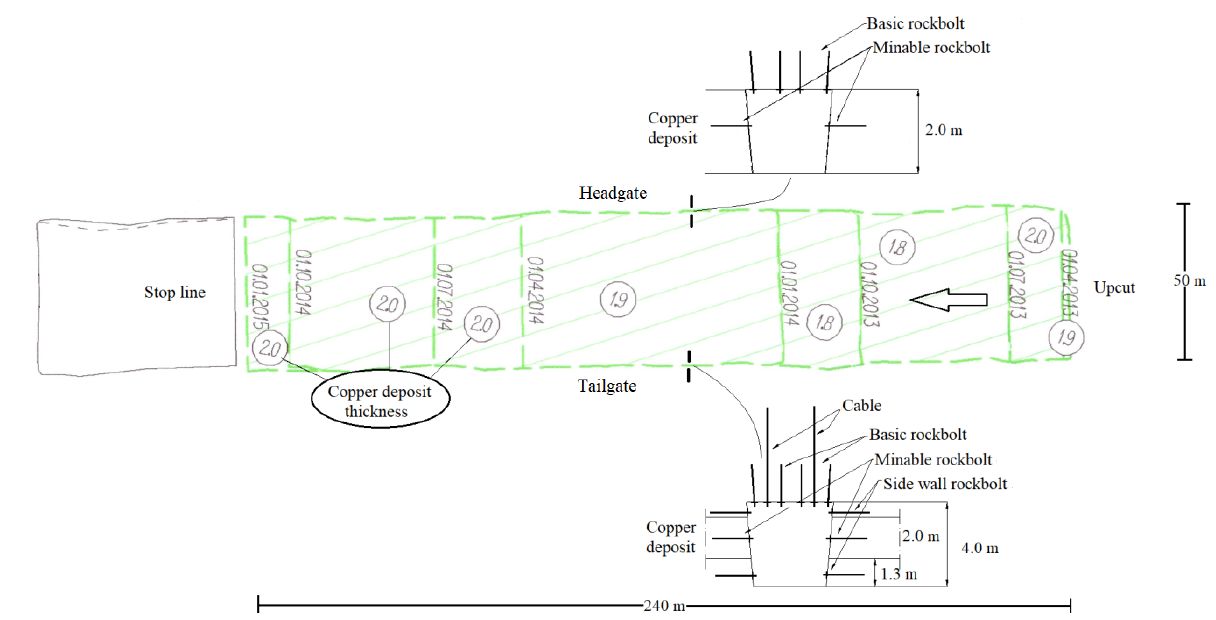
Figure 3: Outline of the A5/1 copper longwall (not to